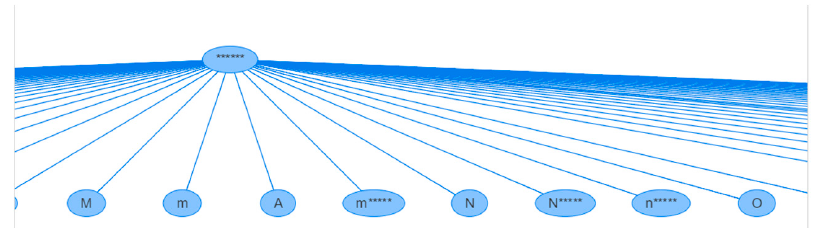
Figure 12. Hierarchy username.